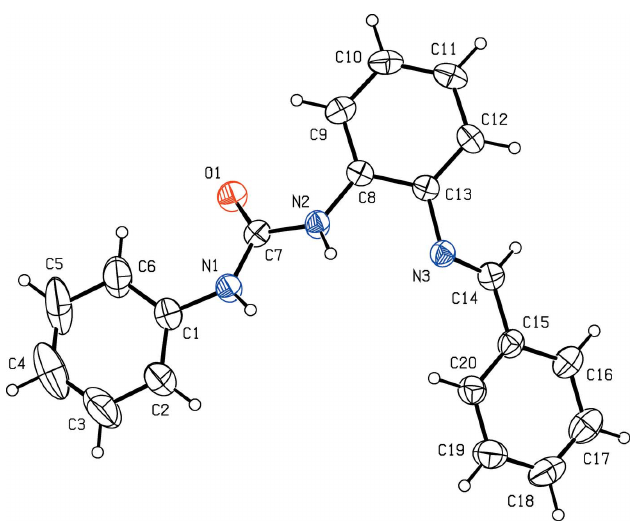
Figure 1 View of the title compound with the atom-numbering scheme. Displacement ellipsoids for non-H atoms are drawn at the 30% probability